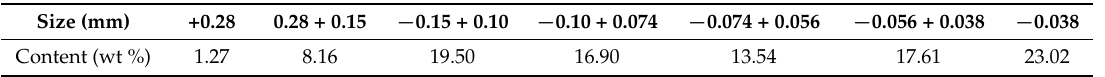
Table 1. The particle size distribution of the titanomagnetite concentrate.